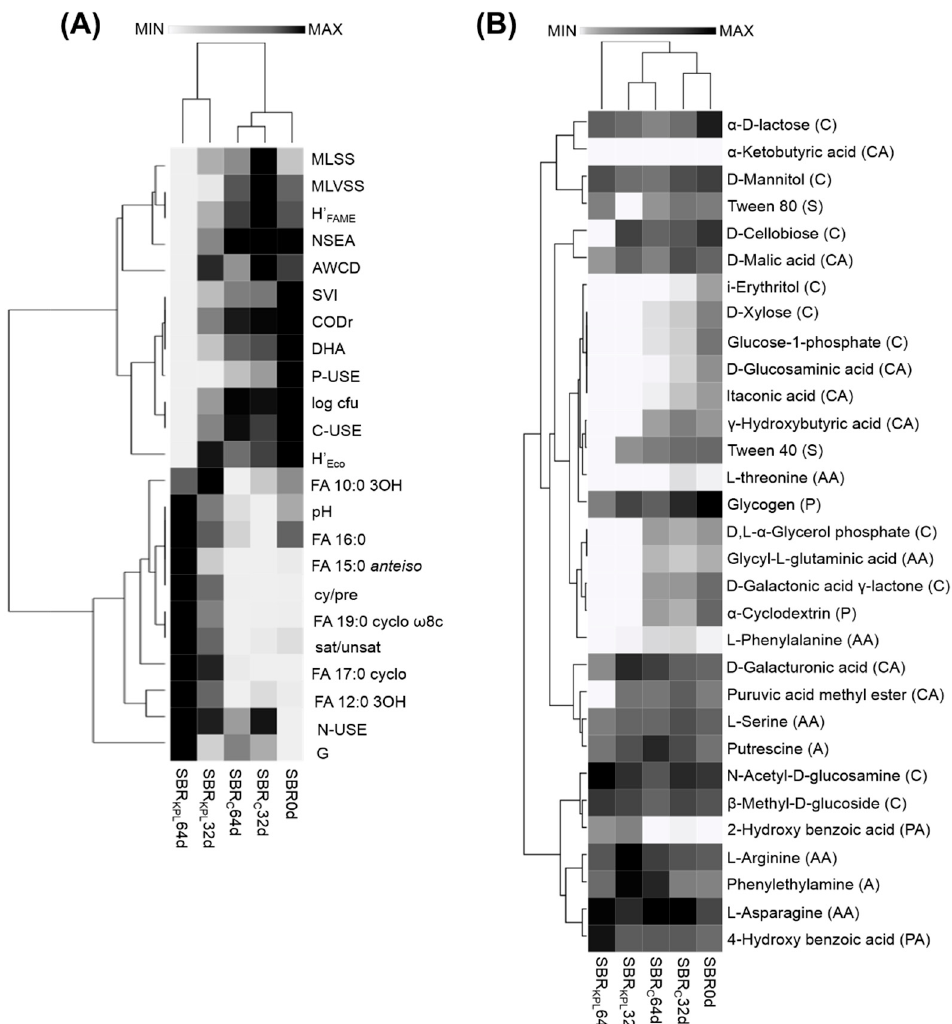
Figure 8. Heat map and cluster analysis based on significant Spearman’s rank correlation coe ffi cients calculated for the operational parameters of the SBR, microbial activity, structural diversity, and functional capacity indices, significant fatty acids, and FAMEs biomarkers ( A ) and Biolog ® EcoPlate TM carbon sources utilization patterns ( B ) at the beginning (0d) and after 32 and 64 days of wastewater treatment in the SBR C and SBR KPL . All data values were normalized and presented as a color scale ranging from white (MIN, 0) to black (MAX,